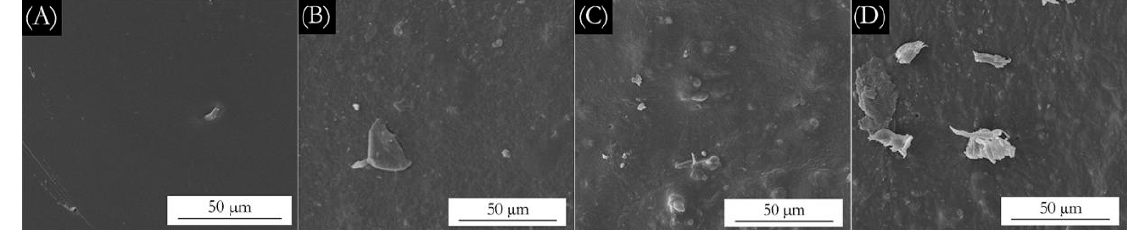
Figure 8. SEM of coating: ( A ) waterborne coating, ( B ) coating with 7.0% aloin, ( C ) coating of 7.0% aloin microcapsules prepared with ethanol as the solvent, and ( D ) coating of 7.0% aloin microcapsules prepared with water as the solvent. Figure 9 is the infrared spectrum of waterborne coating, coating added with 7.0%